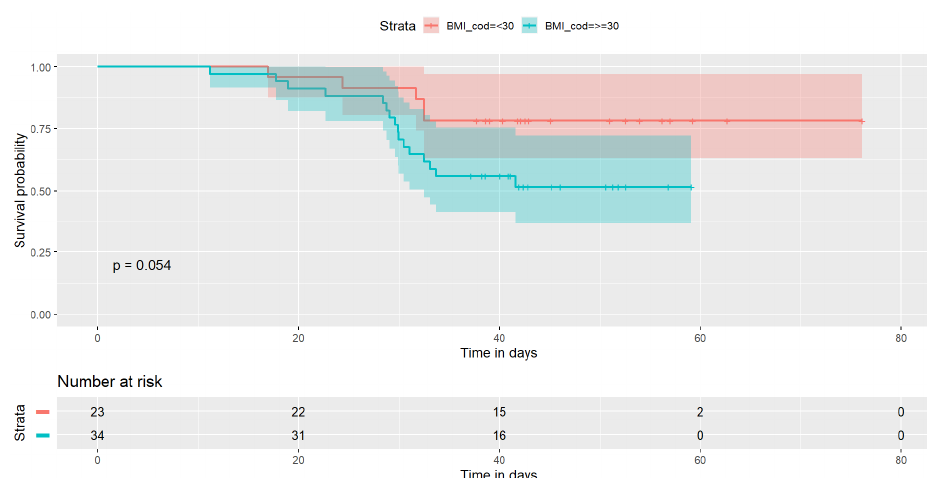
Figure 2. Kaplan–Meier chart stratified for type of mesh. Table 4. Cox regression model for VH recurrence. Characteristic